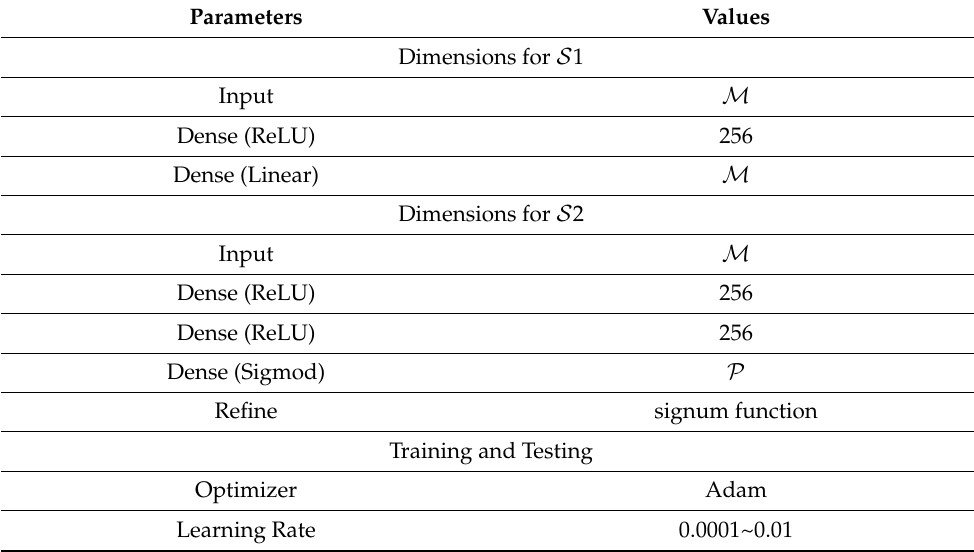
Table 1. Parameters and training of the proposed